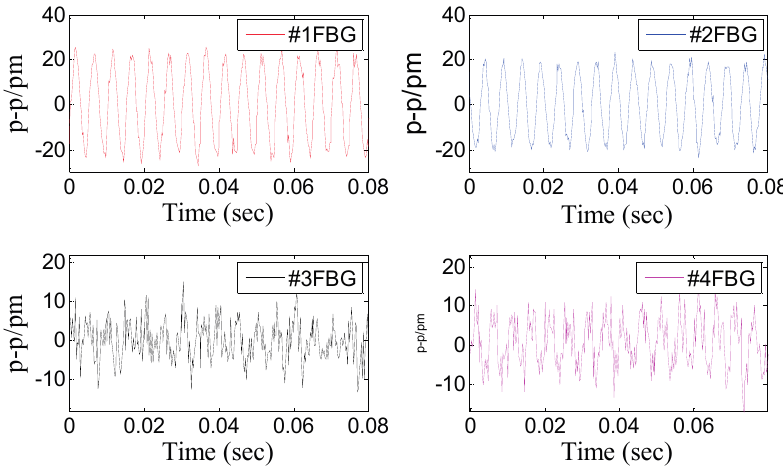
Figure 5. Time domain signal of each FBG under x -direction excitation with the acceleration—10 m/s 2 -200 Hz.